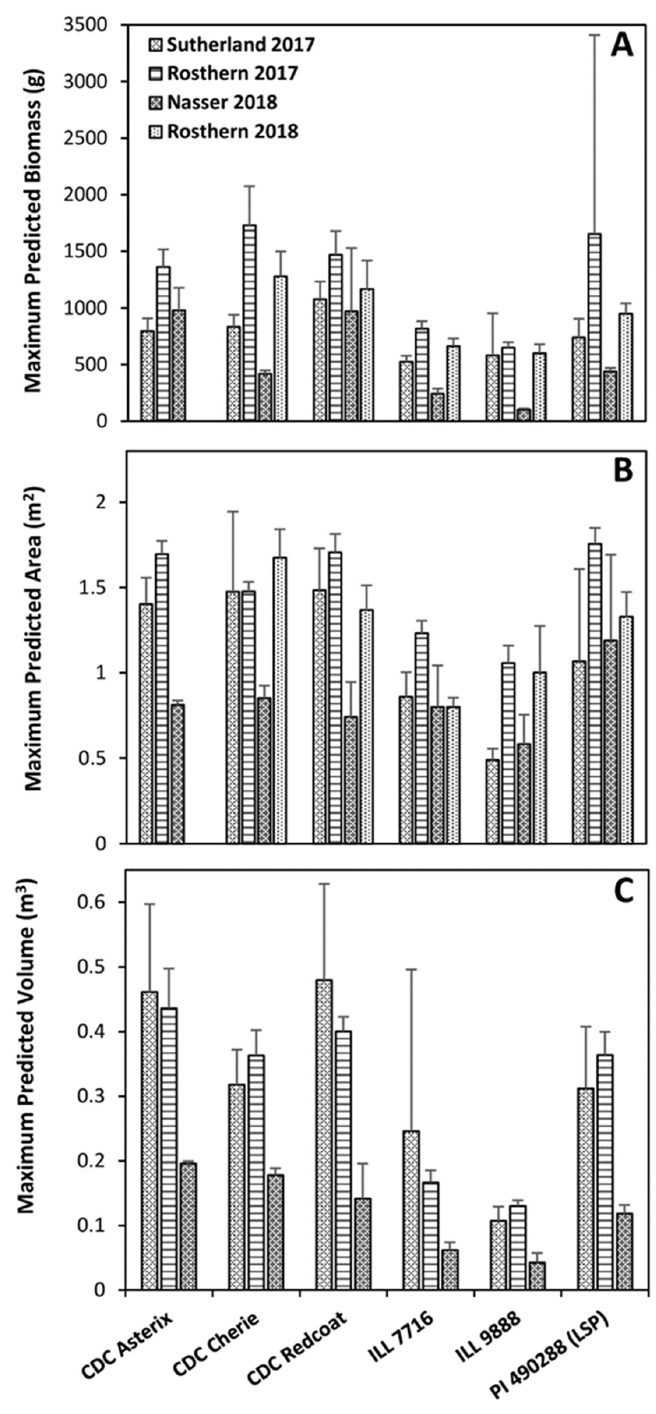
Figure 3. Estimated maximum predicted growth parameters: for dry weight biomass ( A ), vegetation area ( B ), and plot volume ( C ) of each genotype at each site-year. Error bars show standard error.